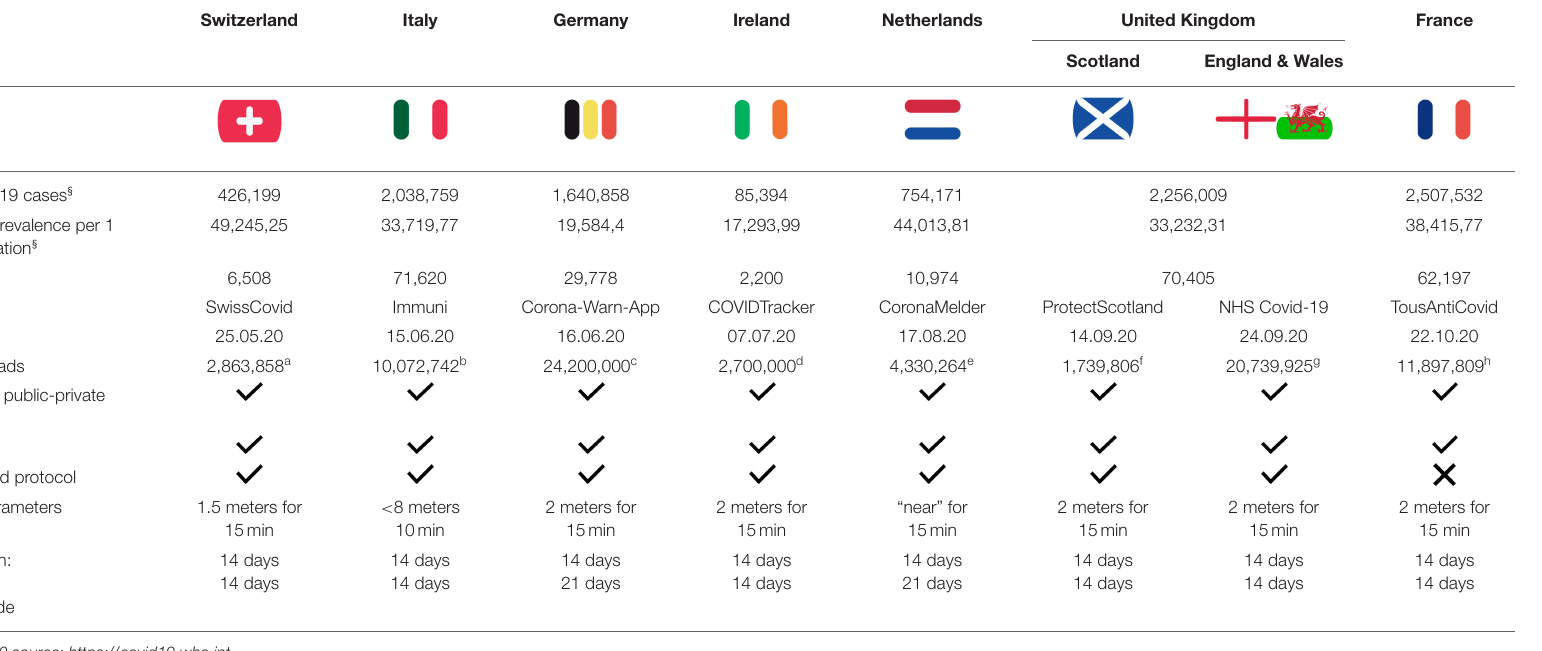
TABLE 1 | Characteristics of DCT systems in selected European